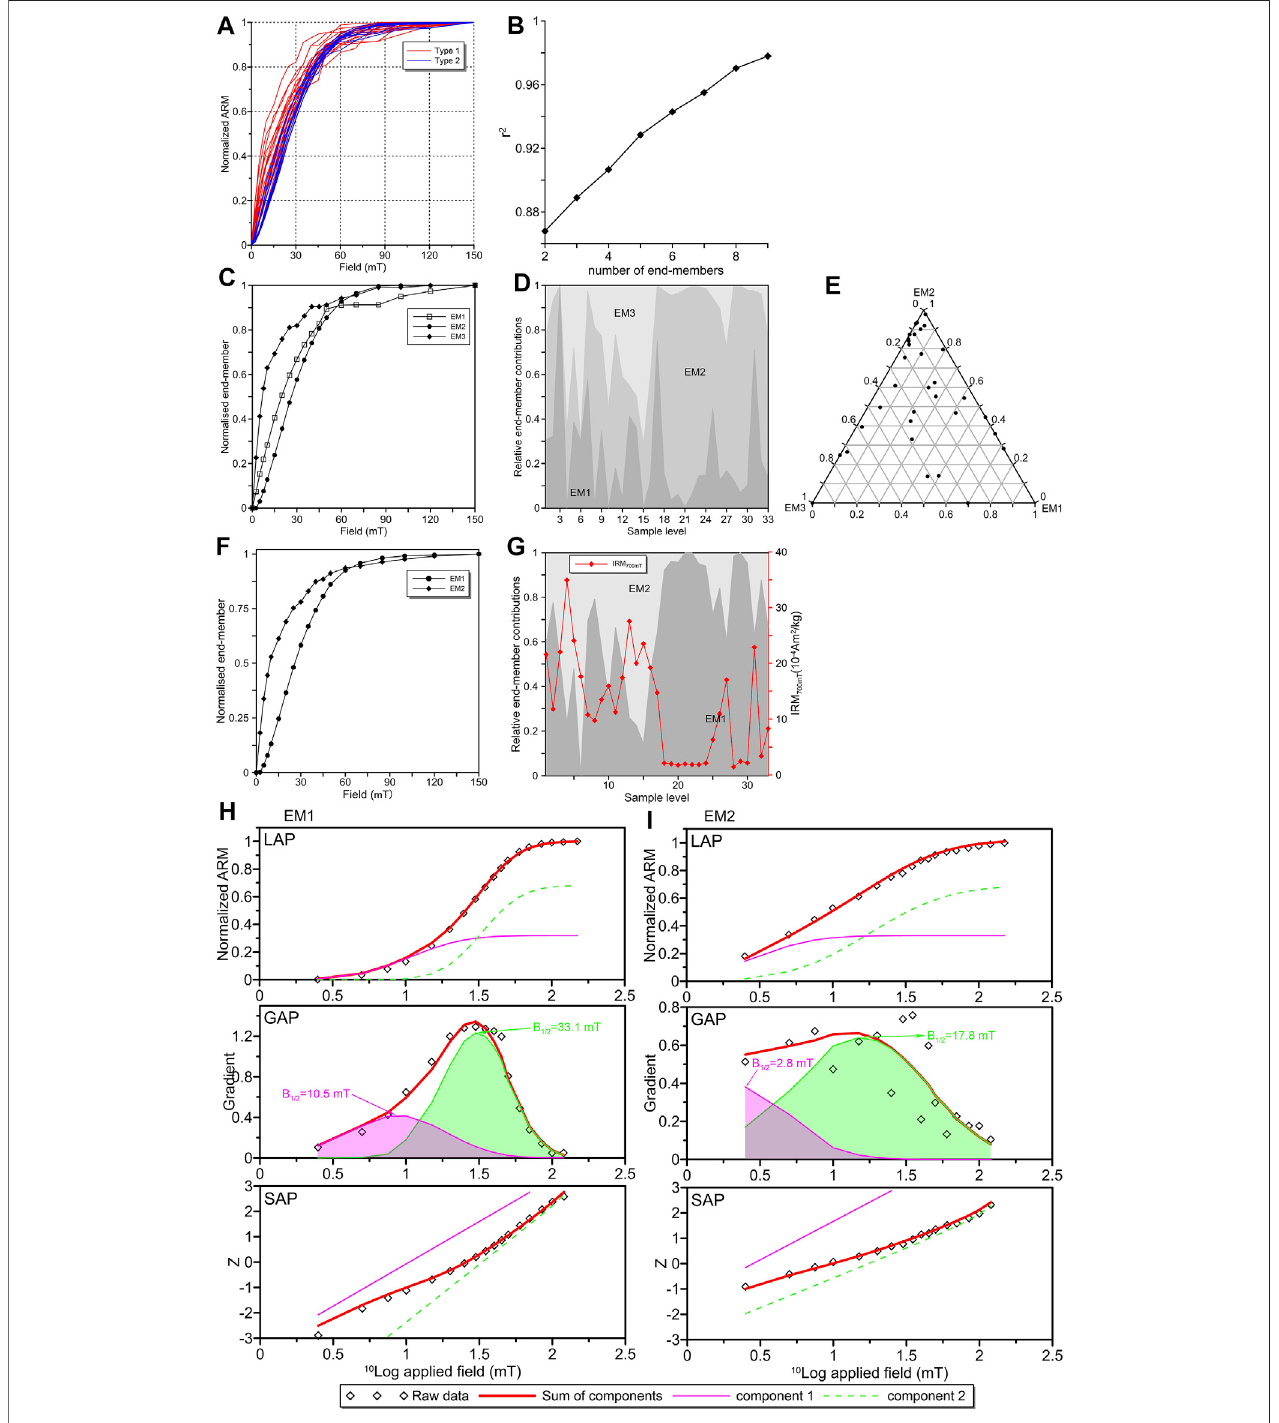
FIGURE 11 | ARM end-member modeling for the Cretaceous granite. (A) Normalized ARM acquisition curves for Type 1 and Type 2 granite. (B) Coef fi cient of determinationversusthenumberofendmembers.End-membermodelingforthenormalizedARMacquisitioncurveswiththree (C – E) andtwo (F,G) end-members. (H,I) ARM component analysis (with the software of Kruiver et al., 2001) ofthe end-members in the two end-member model; colors and symbols are the same asin Panel 5 .